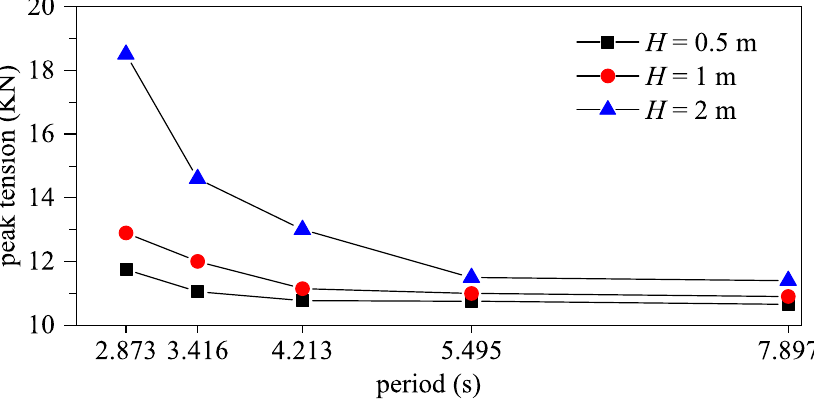
Figure 13. The peak tension of mooring line 1 under 0°